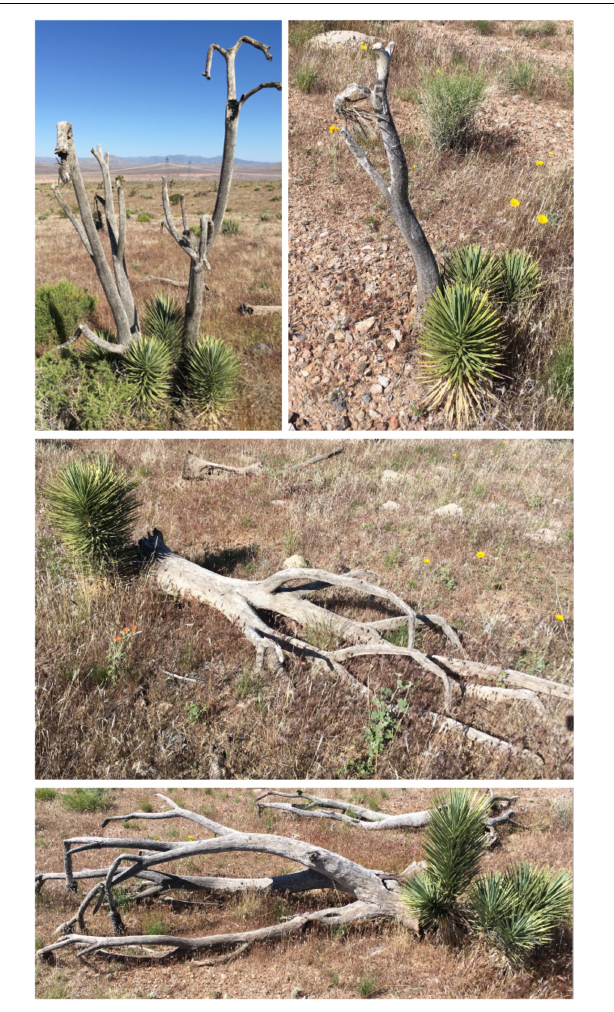
FIGURE 5 | Photos taken along burn interior transects in the spring of 2020 showing Joshua tree sprouts emerging from the base of Joshua trees that burned in the 2005